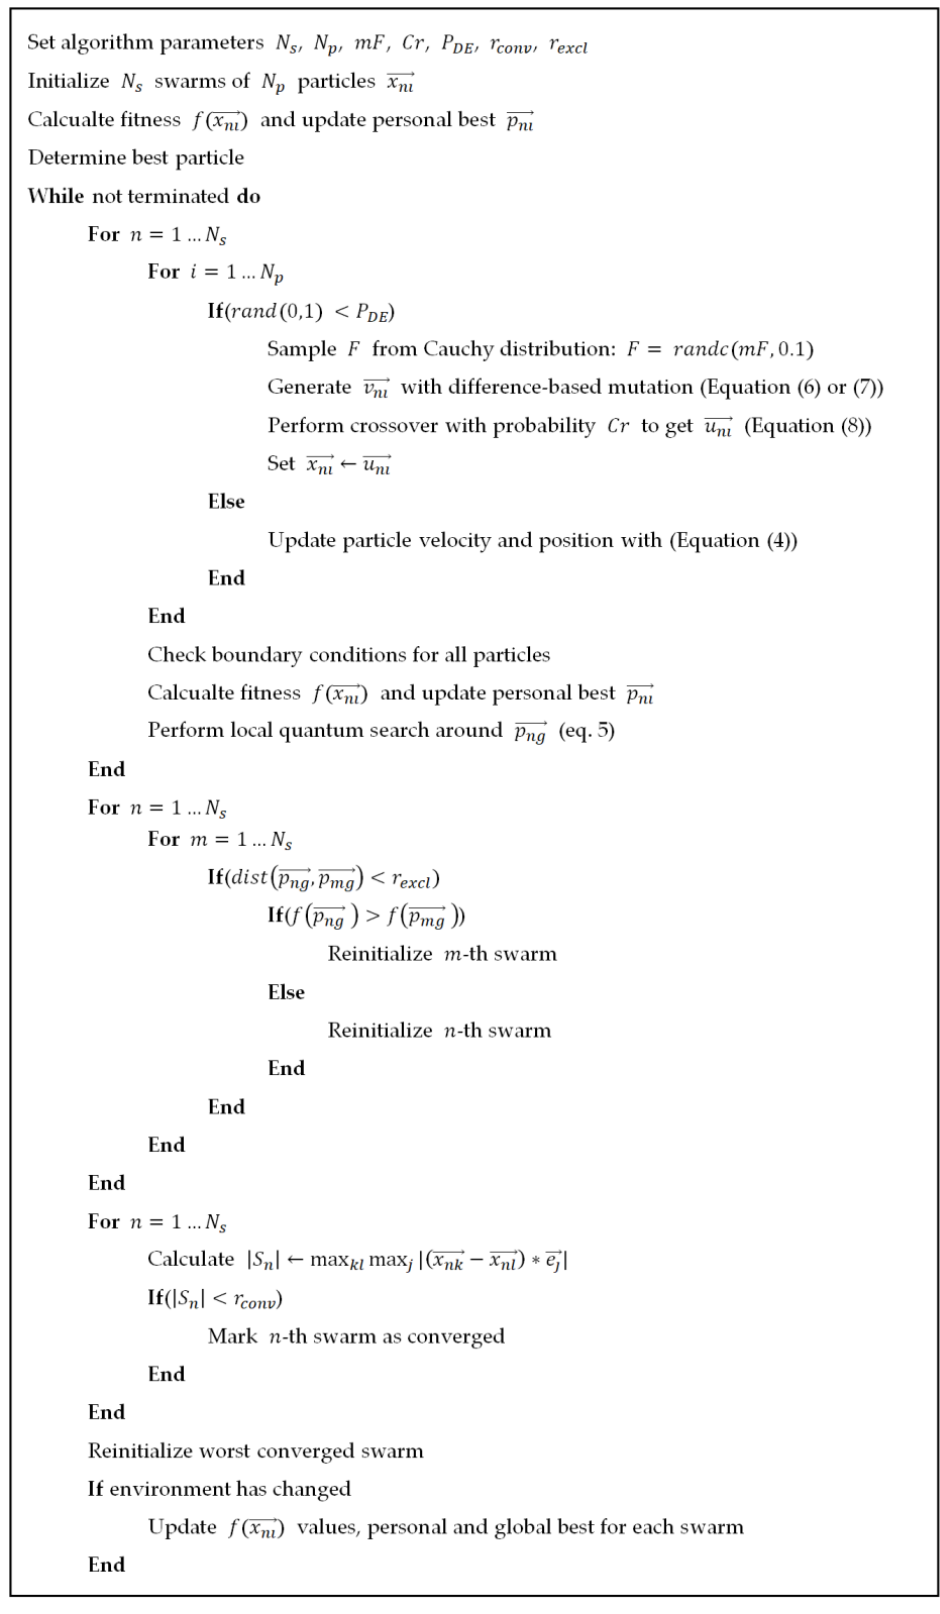
Figure 1. Pseudocode of the proposed mQSODE algorithm.